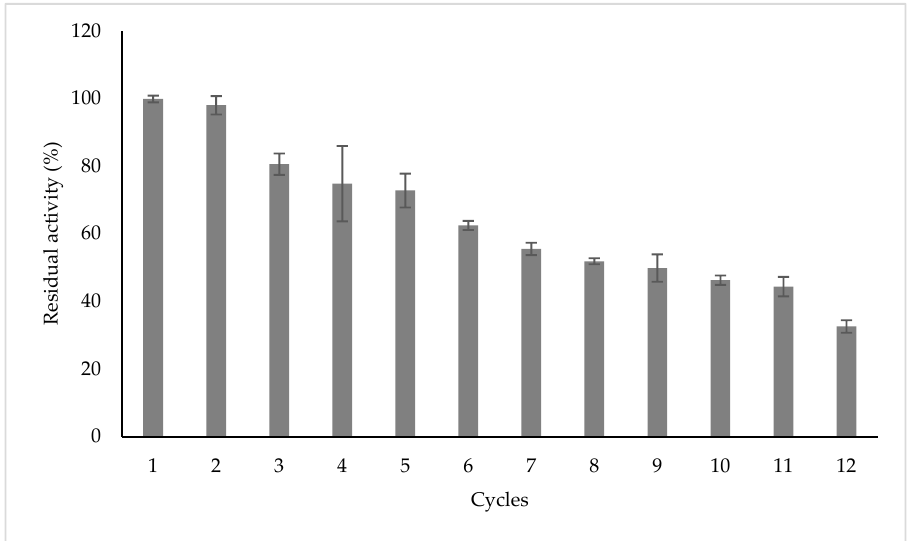
Figure 8. Reusability of CRL/MgO-Al 2 O 3 for 12 cycles. All experiments were performed in triplicate; the error bars represent standard deviations. The first cycle of CRL/MgO-Al 2 O 3 for lipase assay was set as 100%.